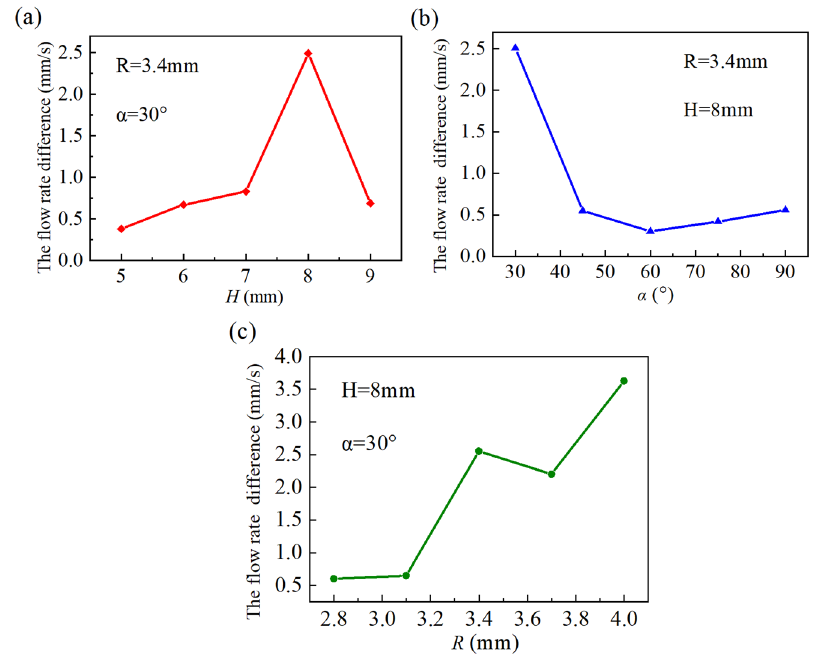
Figure 4. Forward and reverse flow velocity difference: ( a ) Flow velocity difference under different H. ( b ) Flow velocity difference under different α . ( c ) Flow velocity difference under different R.